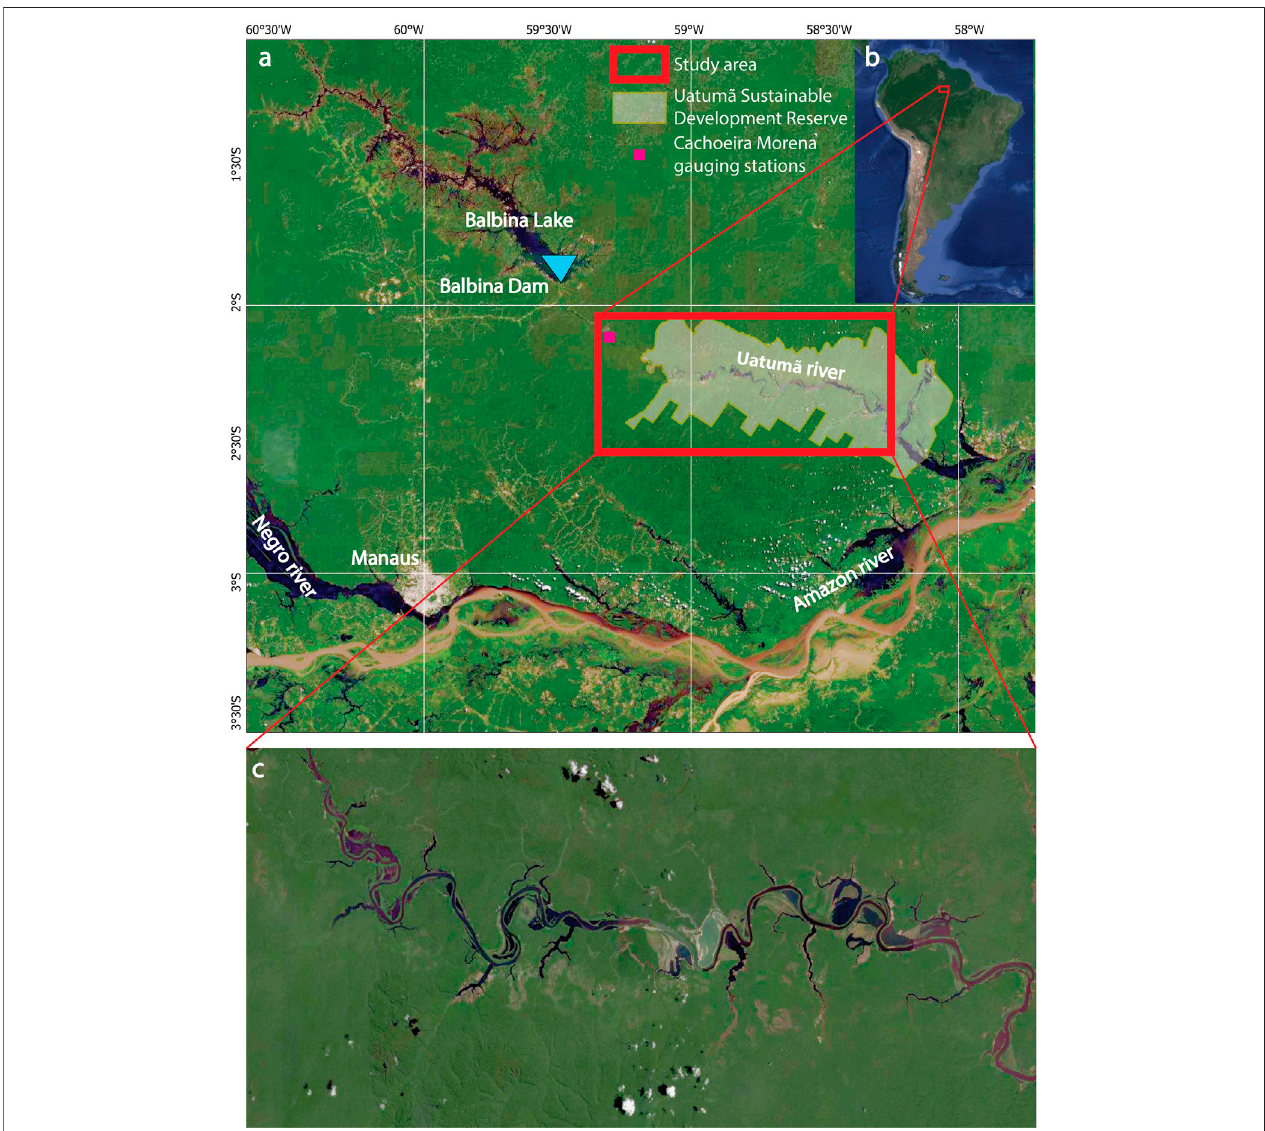
FIGURE 1 | Map of study region. (A) Uatum ~ a river from Balbina Lake to con fl uence with Amazon river. (B) South America and study region. (C) Study area downstream Balbina dam.